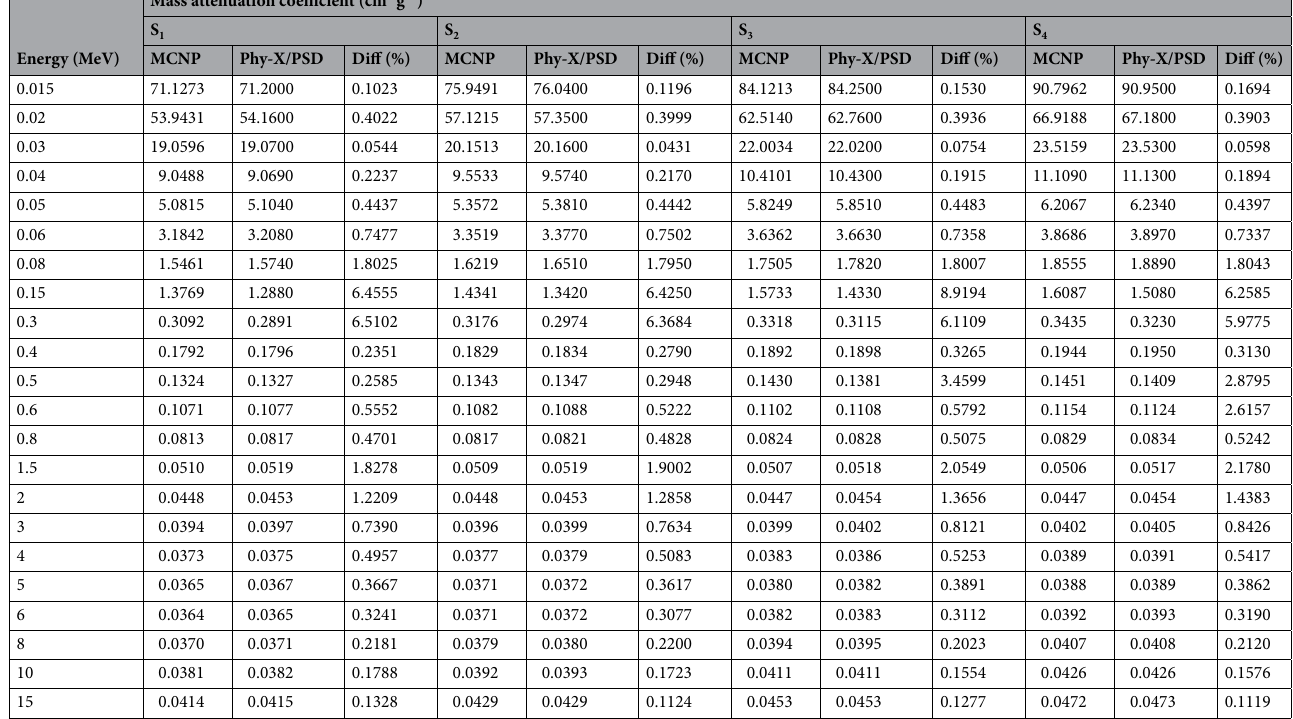
Table 2. Mass attenuation coefficients for the present